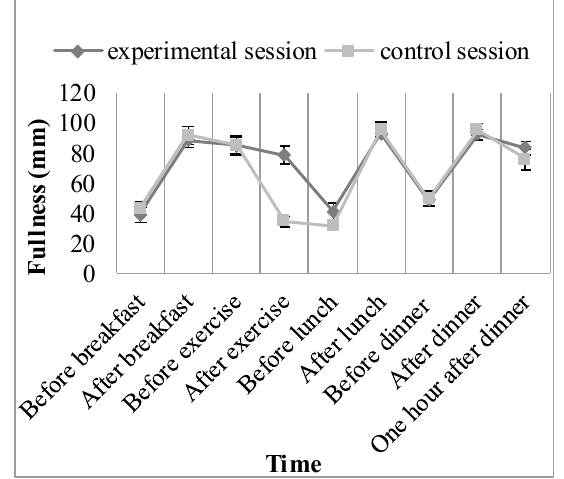
Figure 2. Rating of fullness in the control and experimental session. Values are mean±SD (n=10).